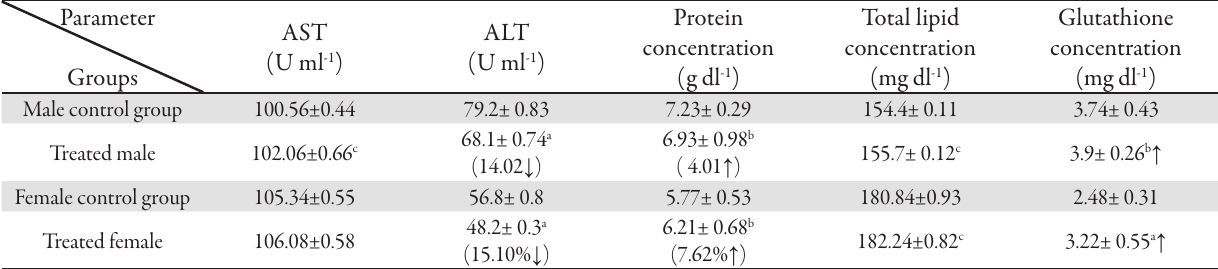
Tab. 3. Serum levels of aspartate aminotransferase (AST), alanine aminotransferase (ALT), protein and glutathione concentration